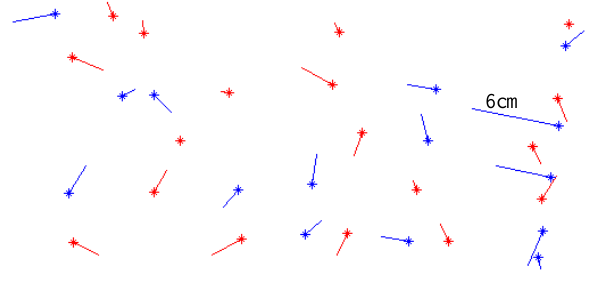
Figure 10: Residuals at GCPs (red) and check points (blue) and their distribution over the building zone for the second epoch processed with Pix4DMapper (projected onto XY-plane)